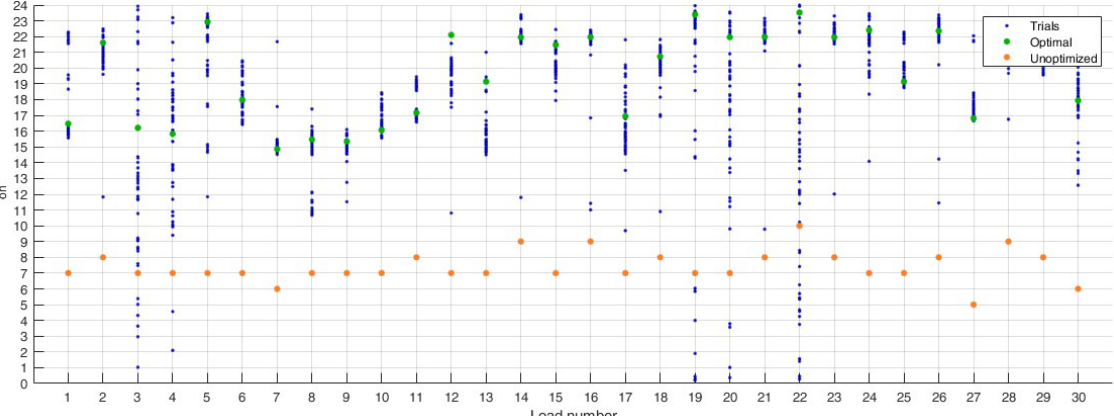
Figure 12. Distribution of the final solutions with the toroidal correction. The algorithm is able to avoid the local minima on the lower boundary of the search